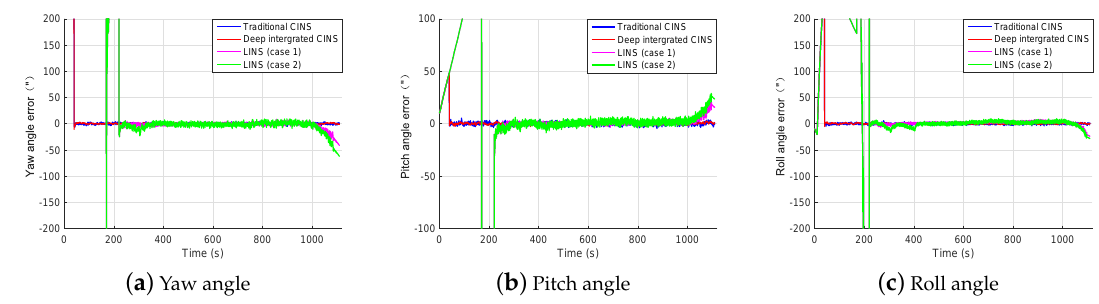
Figure 8. Position estimation errors of different navigation systems.